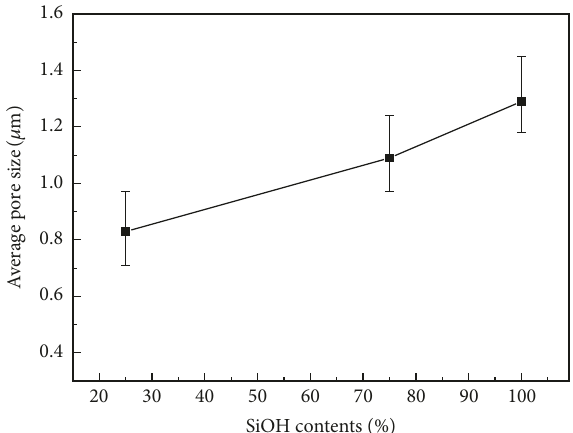
Figure 4: The average pore size as a function of the SiOH contents. Figure 5: Hierarchical porous structure obtained at RH =